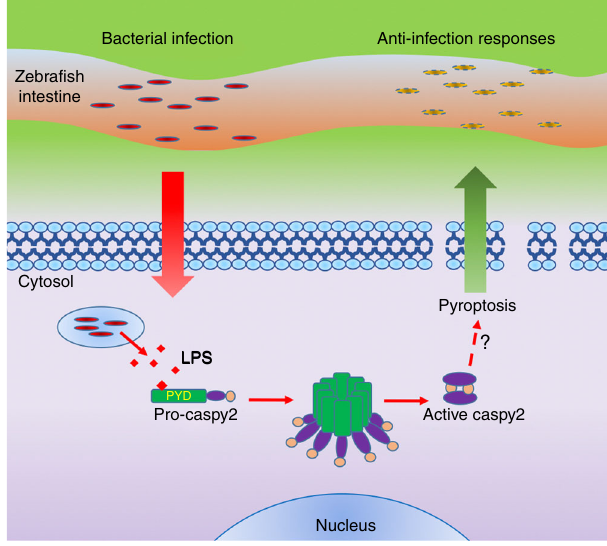
Fig. 7 Proposed mechanism for noncanonical in fl ammasome activation in zebra fi sh. Summary of the caspy2-noncanonical in fl ammasome activation in zebra fi sh illustrating the effects of antibacterial infection effects in